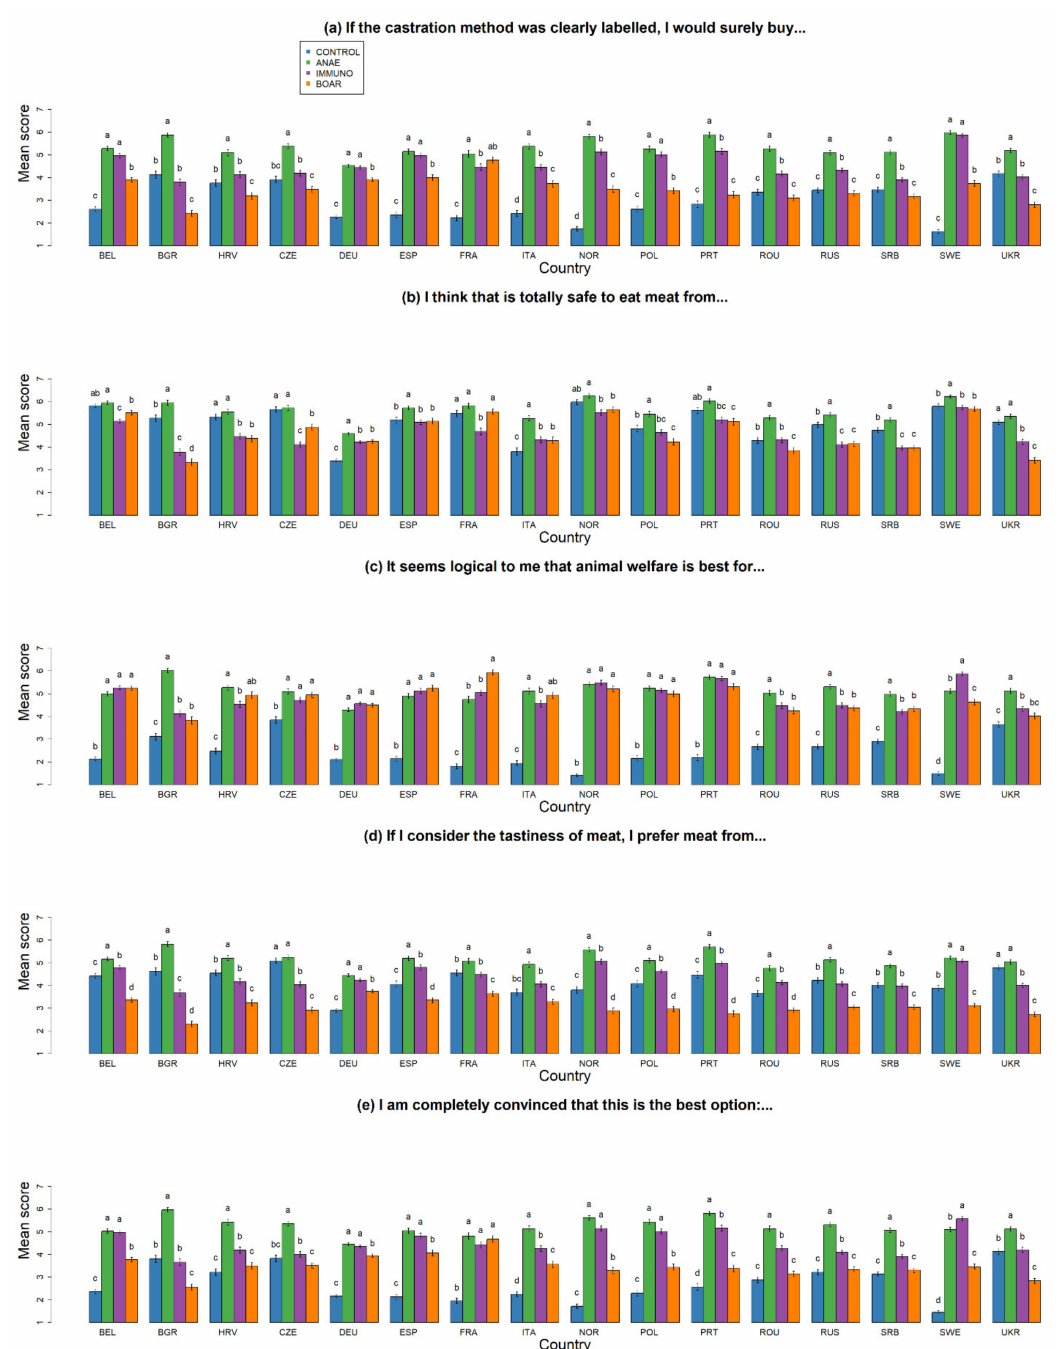
Figure 7. Overall level of agreement towards di ff erent statements for the di ff erent castration alternatives per country ( a ) “If the castration method was clearly labelled, I would surely buy ... ” (WTB), ( b ) “I think that is totally safe to eat meat from ... ” (SAFE), ( c ) “When I think about the following production method, it seems logical to me that animal welfare is best for ... ” (WELFARE), ( d ) “If I consider the tastiness of meat, I prefer meat from ... ” (TASTE), ( e ) ”I am completely convinced that this is the best option ... ” (BEST PRACTICE) for castration without pain relief—CONTROL, castration with anaesthesia—ANAE, Immunocastration—IMMUNO, and no castration—BOAR. a–d di ff erent superscripts indicate significant di ff erences within countries per option ( p <